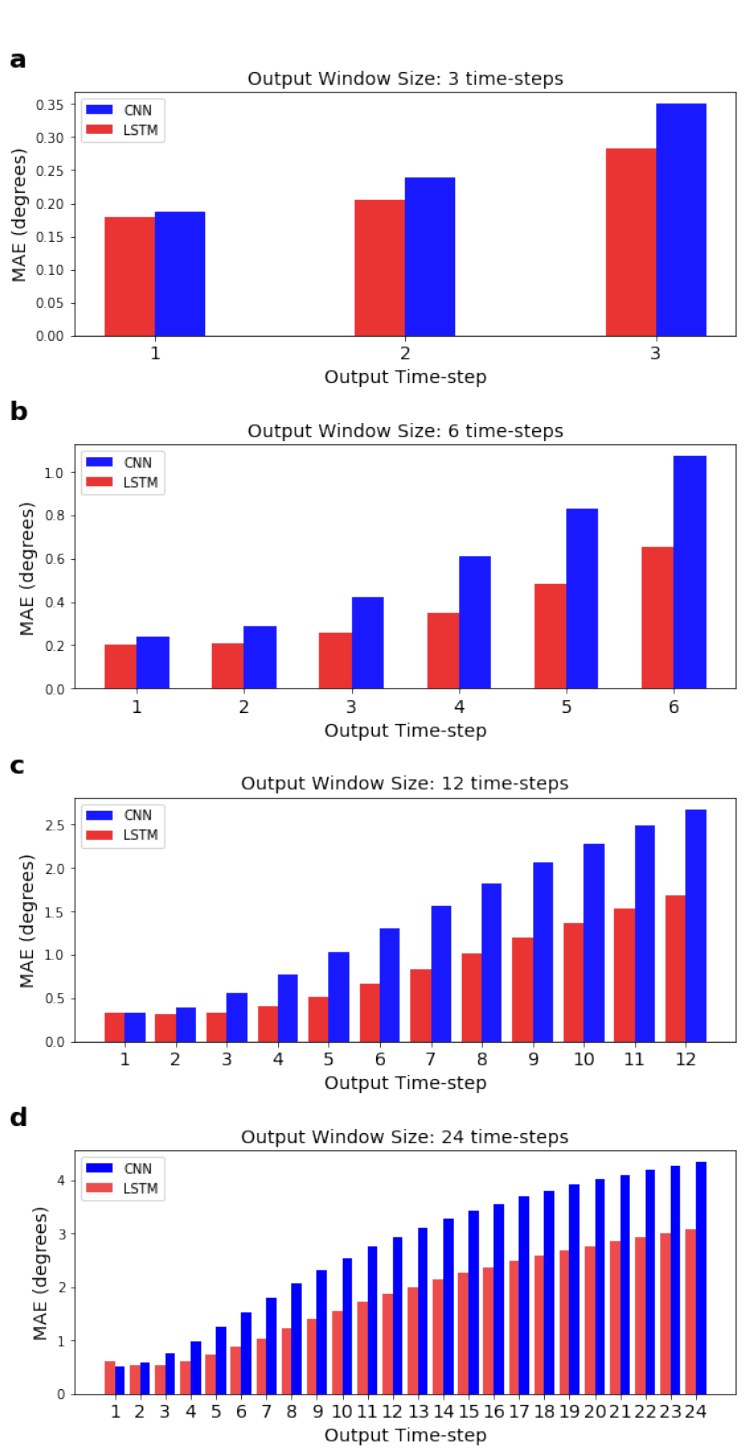
Figure 6. Mean absolute errors for each individual time-step predicted by the LSTM and CNN for a given output window. Input window size is fixed at 120 time-steps. Sub-figures ( a – d ) correspond to networks with 3, 6, 12, and 24 output time-steps,